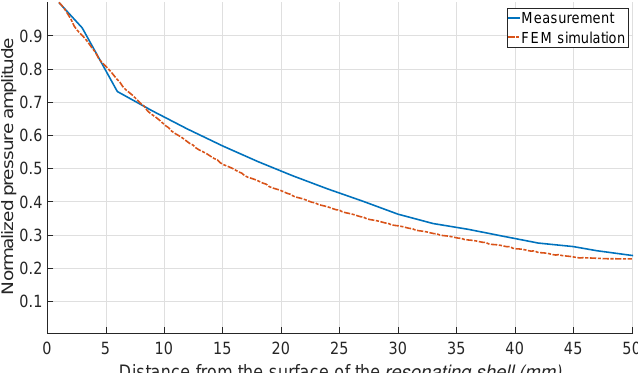
Figure 18. The FEM simulation and measured normalized pressure amplitude of the resonating shell in the near field along the axial distance.